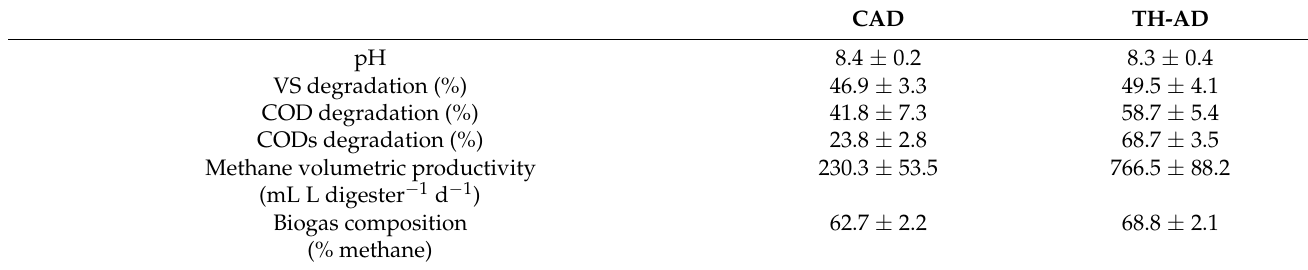
Table 2. Results of the operations of CAD and TH-AD and its respective standard deviation. CAD